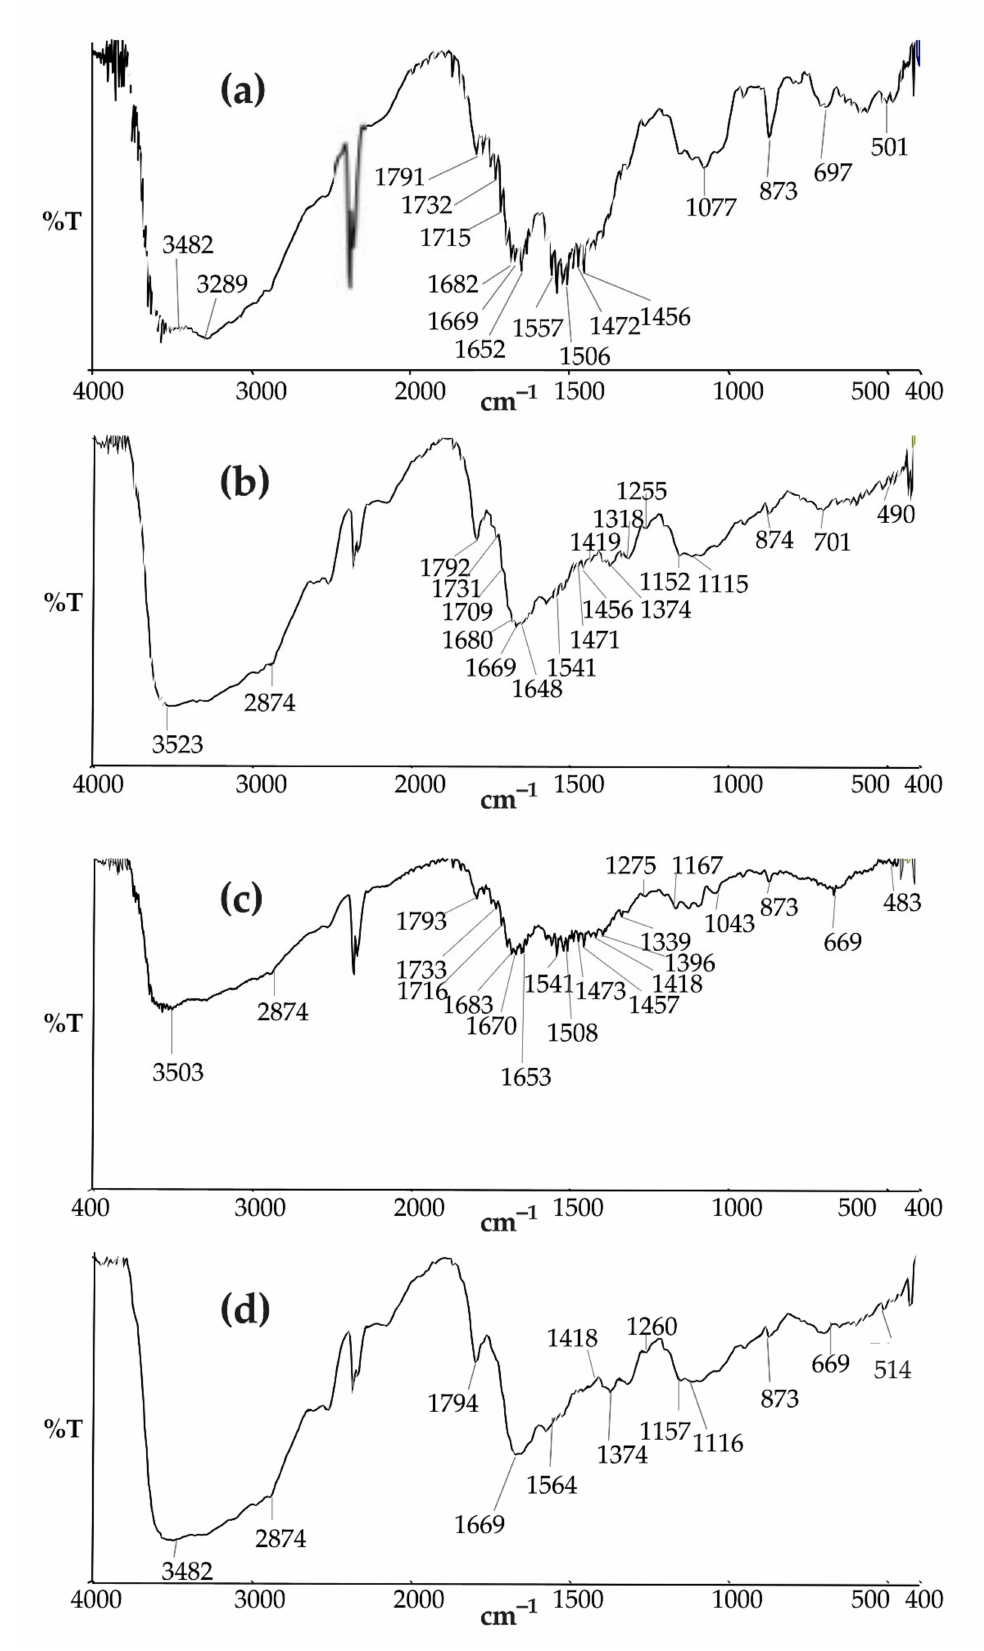
Figure 5. DRIFTS spectra of ( a ) the native CS and the CS loaded with ( b ) Zn 2+ , ( c ) Ni 2+ , and ( d ) Zn 2+ +Ni 2+